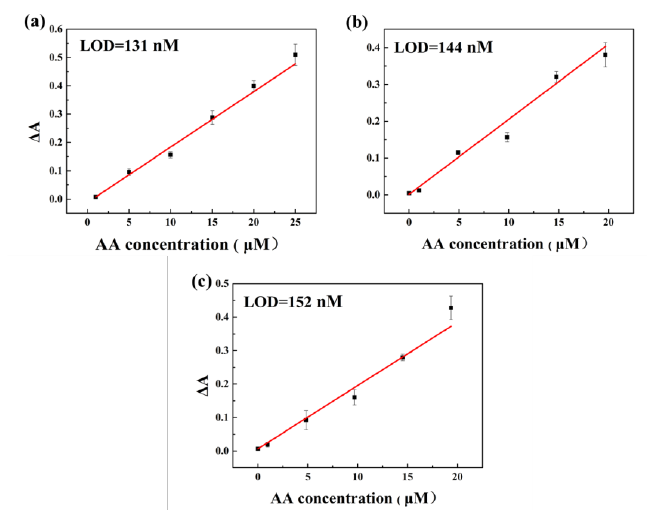
Figure 7. Linear calibration plot for three consecutive detections of ascorbic acid (AA): ( a ) the first time, ( b ) the second time, and ( c ) the third time.